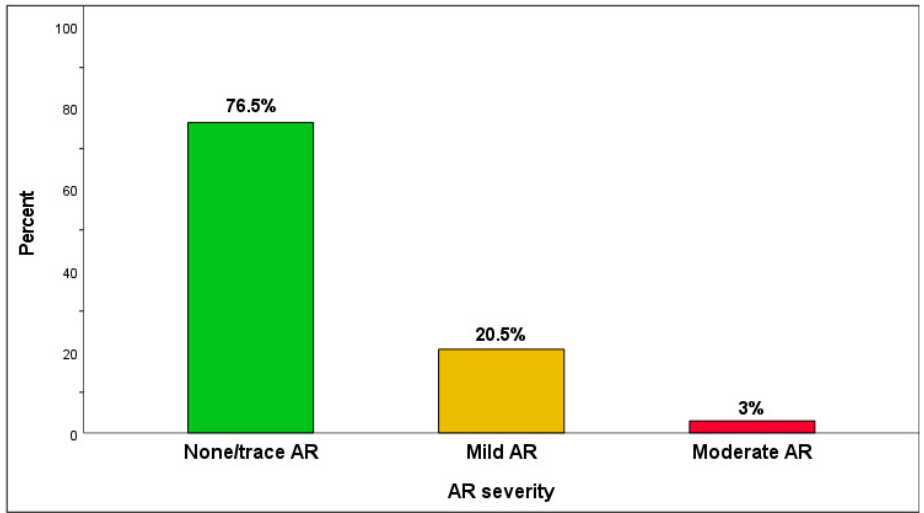
Figure 3. The frequency of aortic regurgitation (AR) severity was assessed with echocardiography at 30 days. Table 5. Hemodynamic performance (echocardiographic assessment at 30 days) of the Myval THV in BAV.